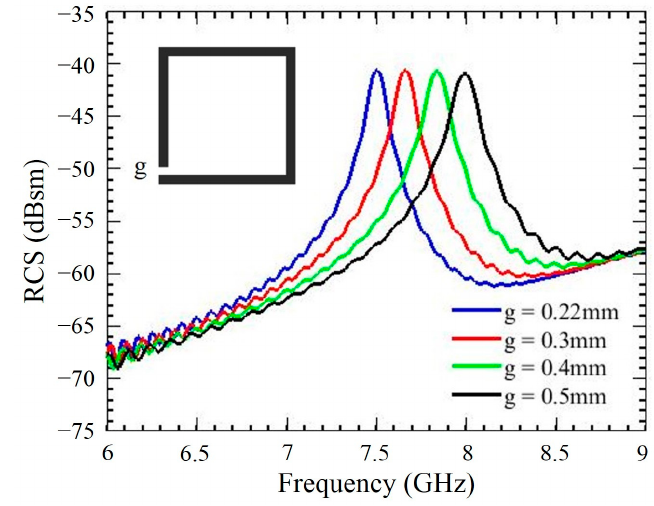
Figure 2. Geometry and simulated RCS response of open-loop resonator.